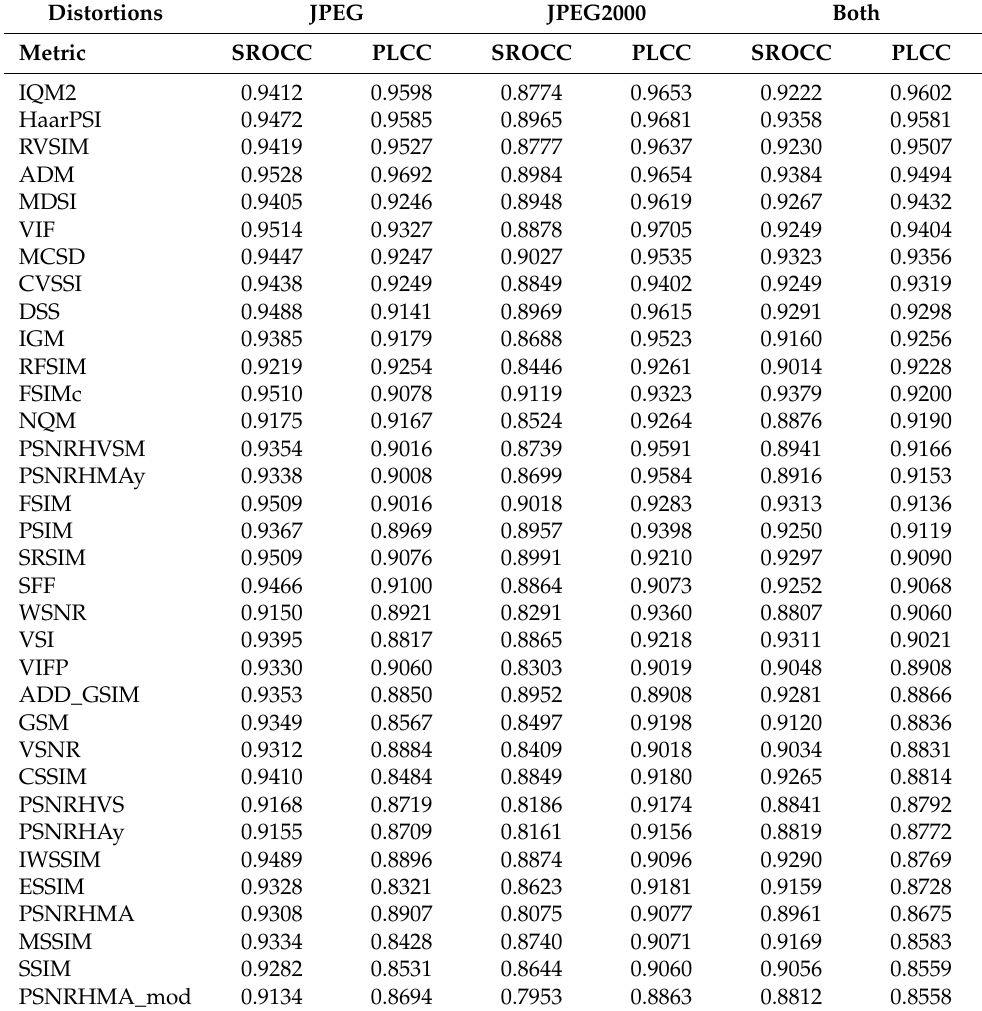
Table A1. Performance of selected elementary metrics for the KADID-10k subsets containing compression-related distortions. Metrics are ordered in descending order according to the PLCC values for both subsets obtained after nonlinear